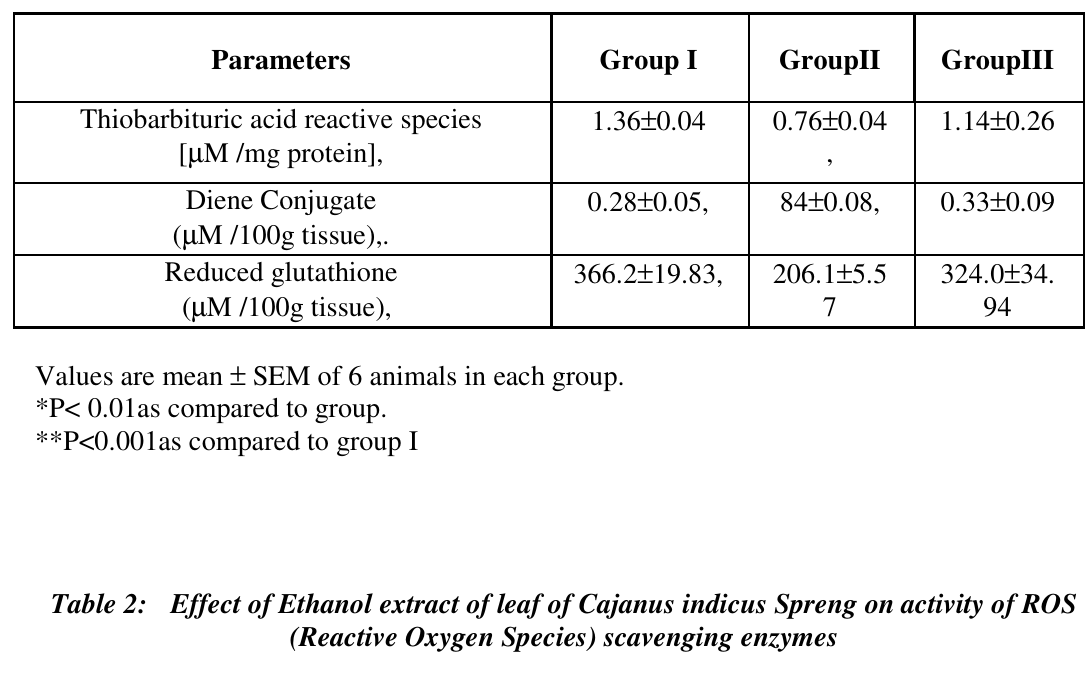
Table 2: Effect of Ethanol extract of leaf of Cajanus indicus Spreng on activity of